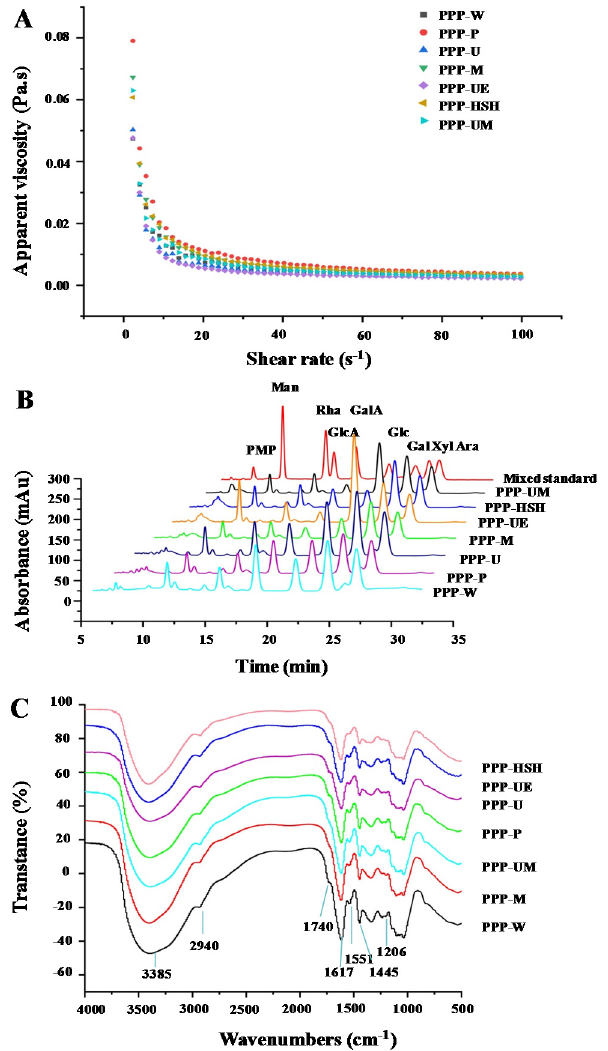
Figure 2. Dependences of apparent viscosities on the shear rate (A), high performance liquid chromatography profiles ( B ), and FT-IR spectra ( C ) of PPPs. The codes of samples were the same as in chromatography profiles (B), and FT-IR spectra (C) of PPPs. The codes of samples were the Table 1; PMP, 1-phenyl-3-methyl-5-pyrazolone, Man, mannose; Rha, rhamnose; GlcA, glucuronic acid; same as in Table 1; PMP, 1-phenyl-3-methyl-5-pyrazolone, Man, mannose; Rha, rhamnose; GalA, galacturonic acid; Glc, glucose; Gal, galactose; Xyl, xylose; Ara, GlcA, glucuronic acid; GalA, galacturonic acid; Glc, glucose; Gal, galactose; Xyl, xylose; Ara, arabinose.